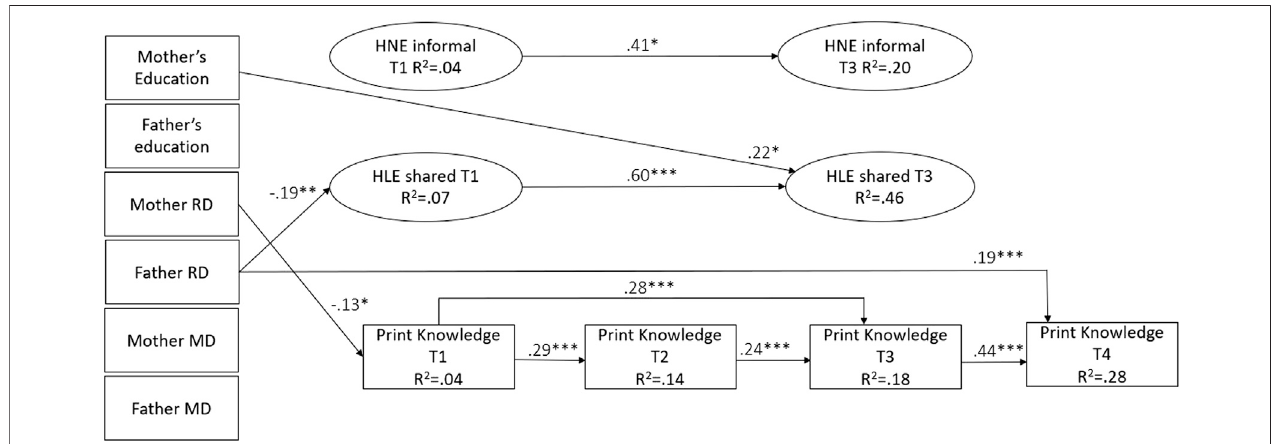
FIGURE 10 | The model for print knowledge with the signi fi cant standardized estimates. Note: In addition to the regression paths depicted, there were three signi fi cant residual correlations: between HNE and HLE at T1 (stand. estimate (cid:1) 0.38***) and between HNE and print knowledge at T1 (stand. estimate (cid:1) 0.24*), and between HLE and print knowledge at T3 (stand. estimate (cid:1) − 0.27**).